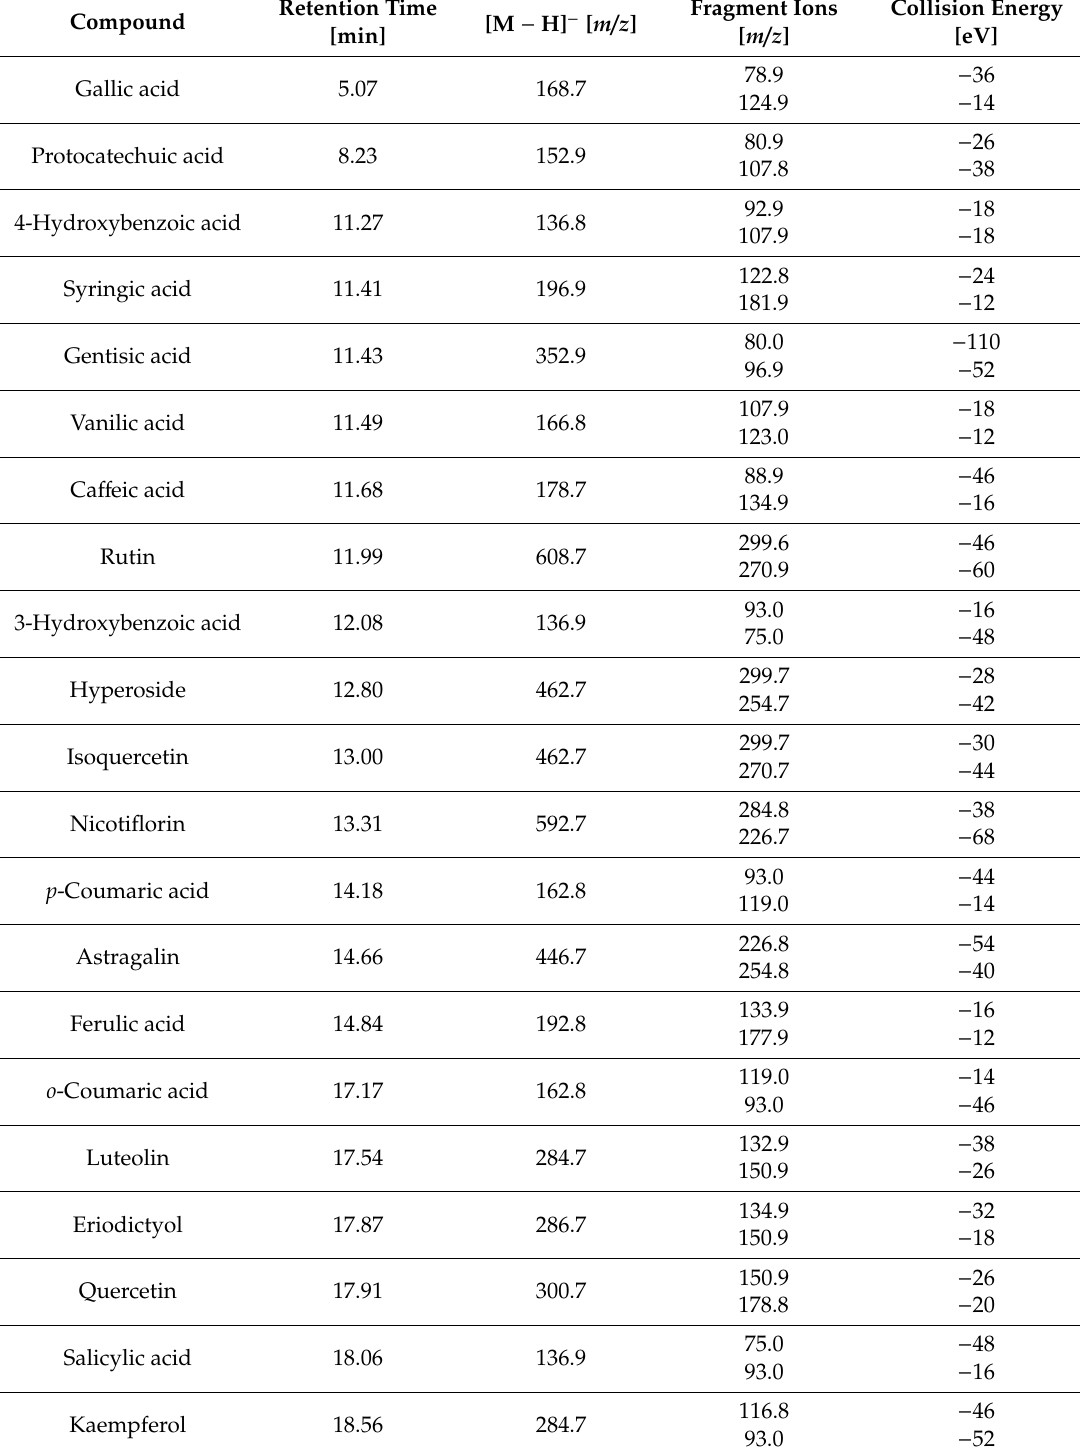
Table 1. Liquid chromatography–electrospray tandem mass spectroscopy (LC-ESI-MS / MS) analytical results of phenolic acids and flavonoids investigated in the extracts, which were confirmed by comparison with reference